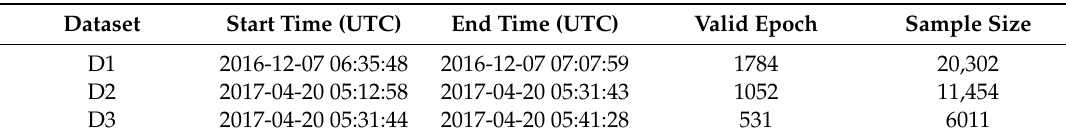
Table 1. Valid epoch and sample size of each dataset.